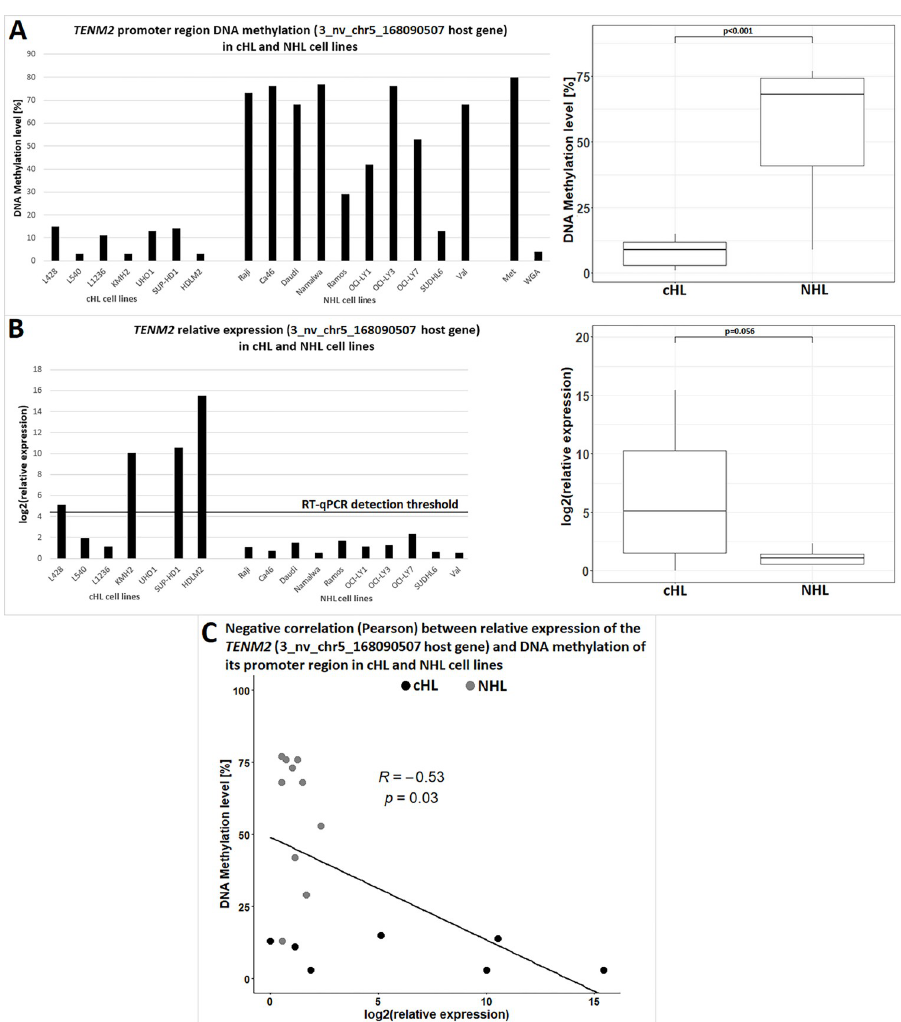
Fig 5. Comparison of DNA methylation level of the TENM2 promoter region with relative expression of this gene. Bars represent methylation of one CG dinucleotide analysed by the bisulfite pyrosequencing assay (A) and TENM2 relative expression (B) . Statistically significant negative correlation between TENM2 relative expression and DNA methylation in cHL (black dots) and NHL cell lines (grey dots) (C)